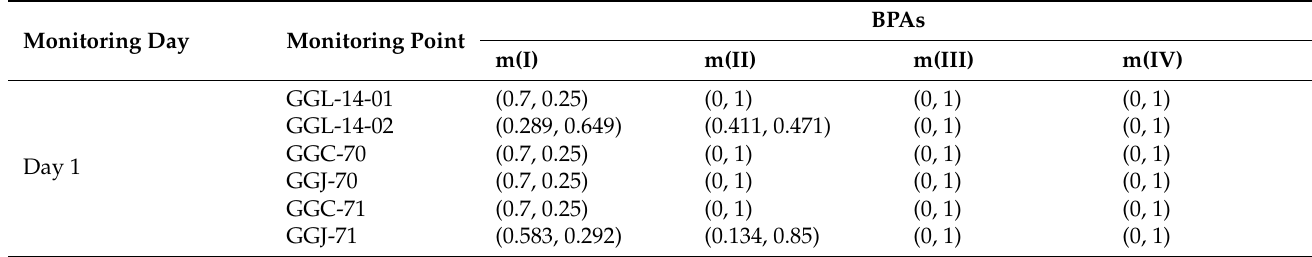
Table 10. BPAs of influential factors during construction on Day 1.